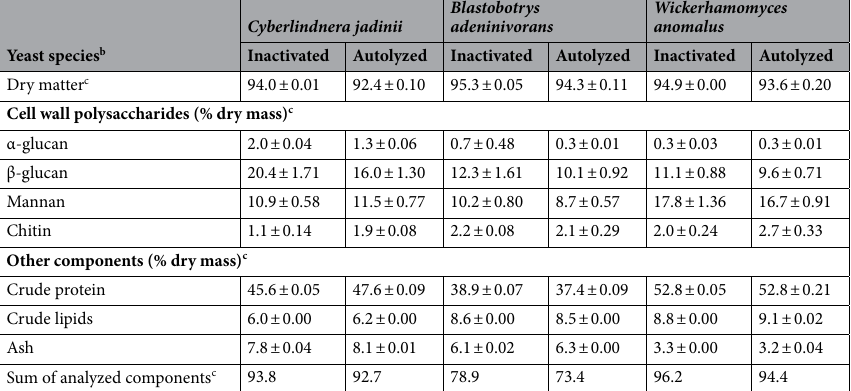
Table 1. Composition of yeast cells with and without autolysis treatment, after the drying process a . a Cell wall thickness (nm): Inactivated Cyberlindnera jadinii = 95.9, autolyzed C. jadinii = 80.9, inactivated Blastobotrys adeninivorans = 103.6, autolyzed B. adeninivorans = 62.2, inactivated Wickerhamomyces anomalus = 161.4 and autolyzed W. anomalus = 116.5. b Composition of ref- Cyberlindnera jadinii (% dry weight): α-glucan = 0.9, β-glucan = 15.0, mannans = 9.4, chitin = 1.9, dry matter = 93.2, crude protein = 58.1, crude lipids = 7.0 and ash = 5.4. This is the same yeast used in Grammes et al. 15 . c Amounts of α-glucans, β-glucans and mannans of the cell wall are mean value ± SD from triplicate analyses; whereas chitin, dry matter, crude protein, crude lipids and ash were from duplicate analyses. d Sum of analyzed components is equal to sum of the cell wall polysaccharides and other components in the yeast